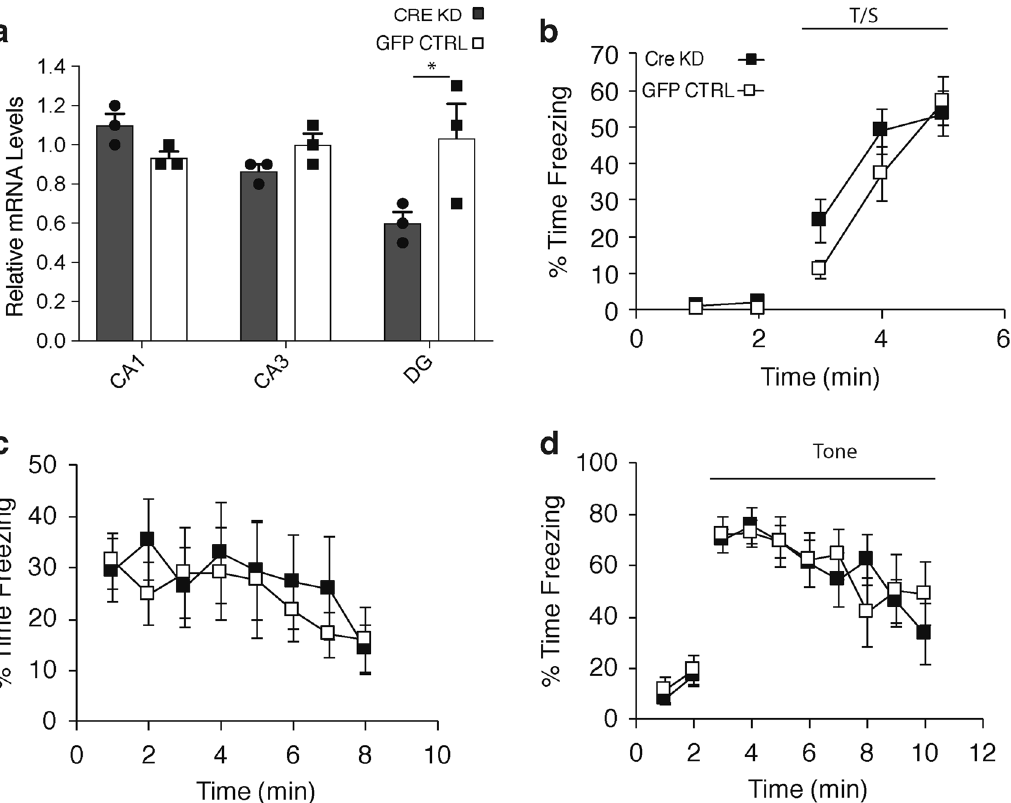
Fig. 4 DG-speci fi c Nampt knockdown mice do not show cognitive hypersensitivity. a Nampt mRNA levels in the CA1, CA3, and DG regions of DG-speci fi c Nampt knockdown and GFP-injected control mice ( n = 3 mice for each group; * p < 0.05, unpaired Student ’ s t -test). b – d Contextual fear conditioning tests were conducted on DG-speci fi c Nampt knockdown ( n = 7) and GFP-injected control ( n = 6) mice. No signi fi cant main effects of group or group by time interactions were found from the analyses conducted for any of the components of the fear conditioning procedure. Values of percent time freezing are shown from the tone-shock (CS-US) training period on day 1 ( b ), contextual fear conditioning on day 2 ( c ), and the auditory cue period on day 3 ( d ). No statistical differences were detected by two-way rmANOVA. Data are presented as mean ±